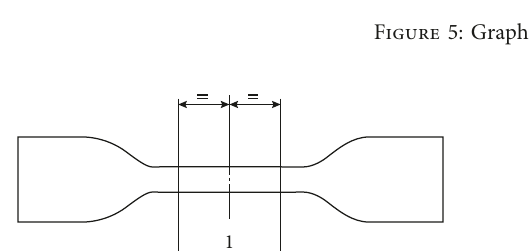
Figure 5: Graph of rubber tensile test.